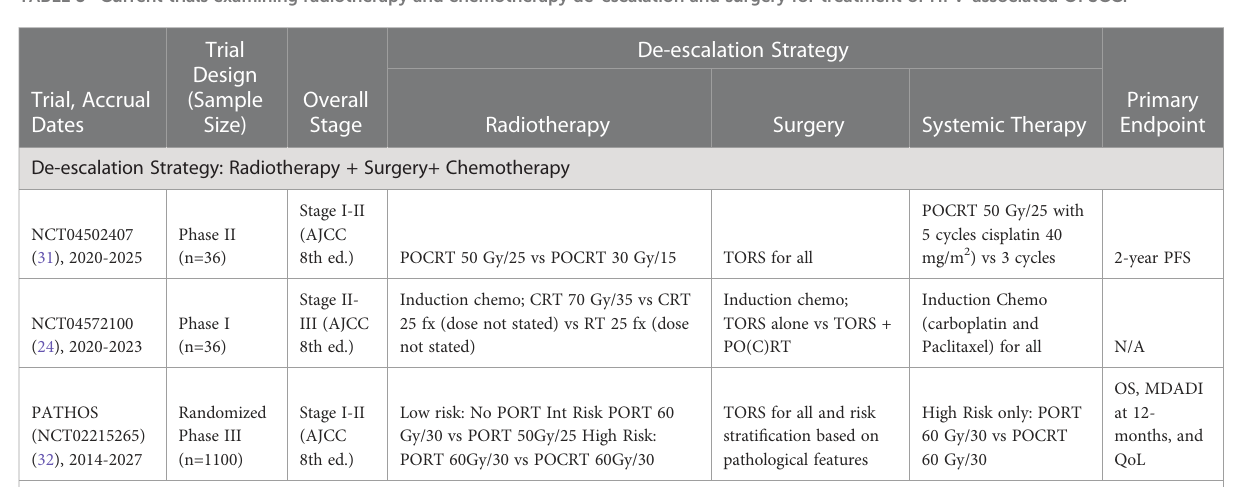
TABLE 5 Current trials examining radiotherapy and chemotherapy de-escalation and surgery for treatment of HPV-associated OPSCC.